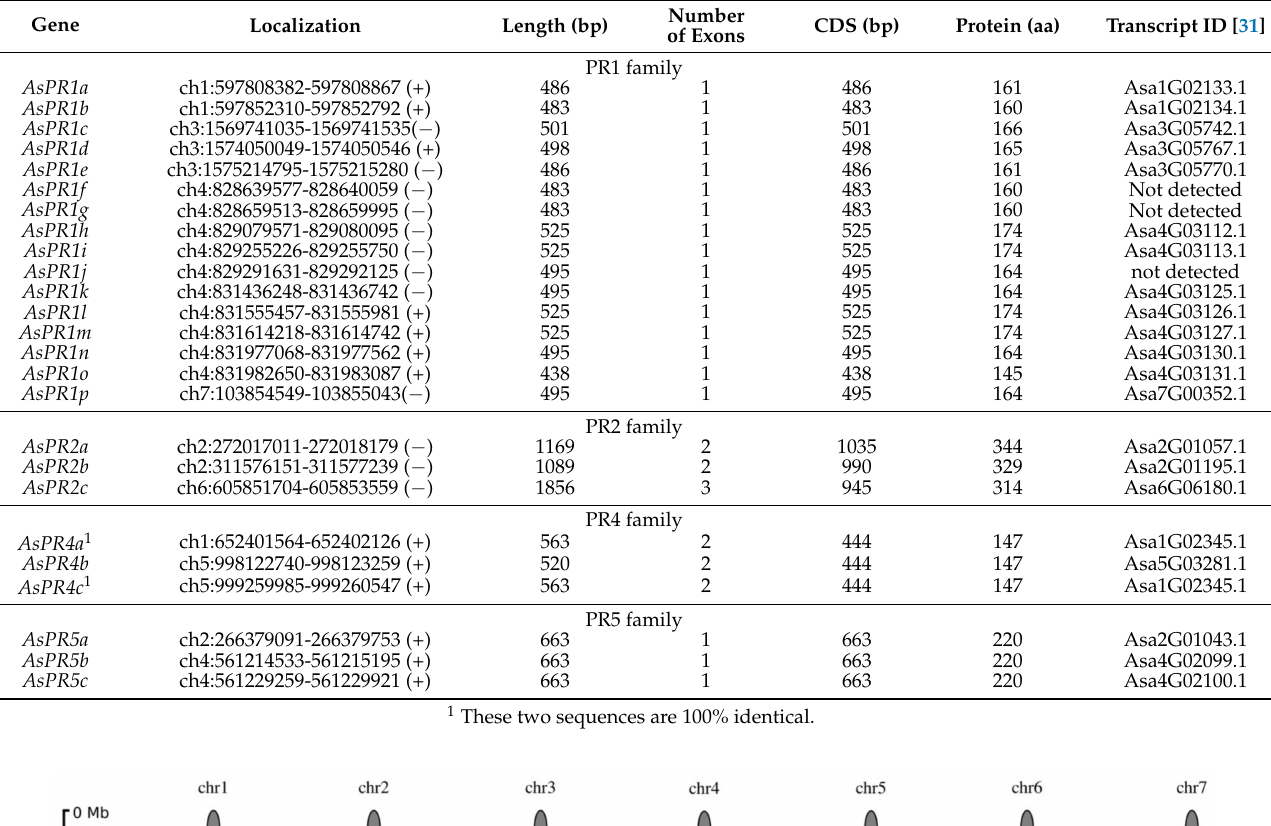
Table 1. PR1 , PR2 , PR4, and PR5 genes identified in the genome of A. sativum cv. Ershuizao.